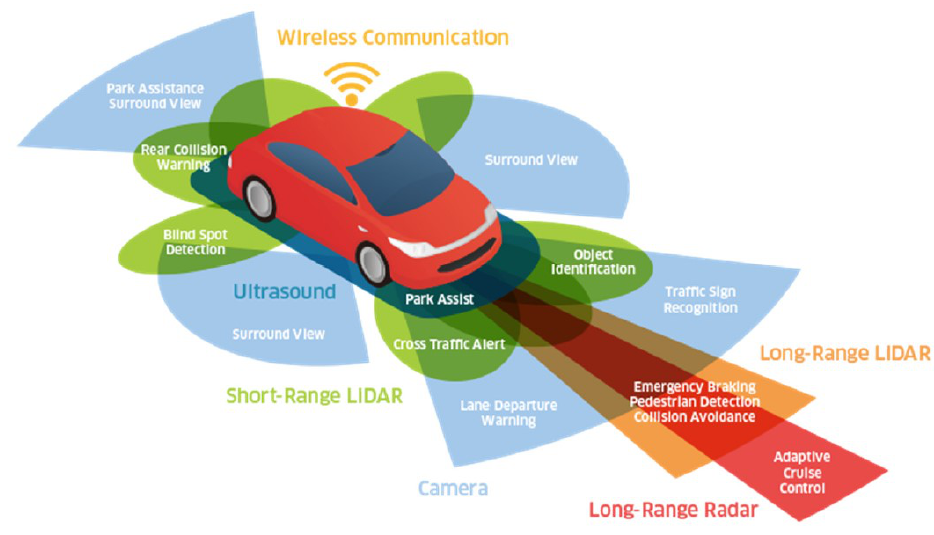
Figure 1. Sensors coverage diagram for an autonomous vehicle, taken from